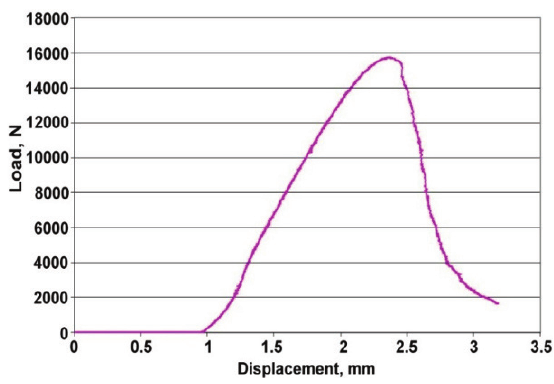
Figure 3. The load-displacement curve for Arcan test in mode-I with the initial crack length of 7.30 mm.